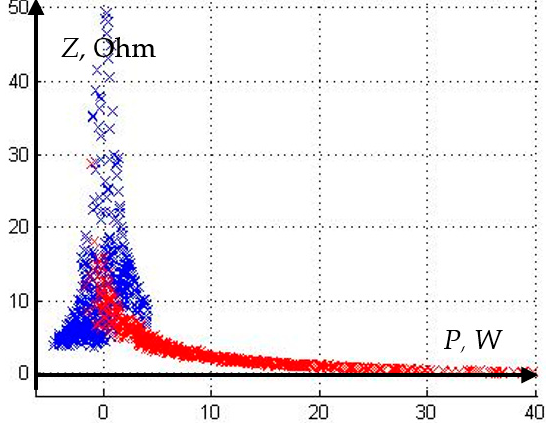
Figure 7. Location of training sample points in feature space ( P–Z ).